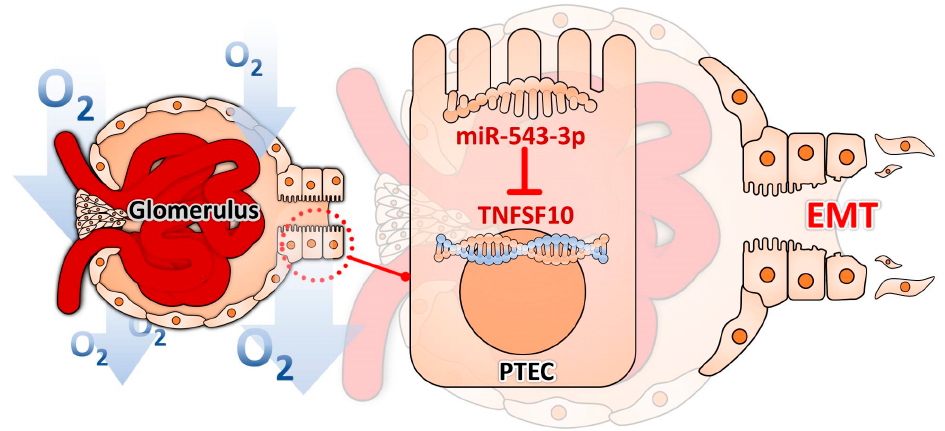
Figure 5. Illustration of the mechanism by which hypoxia induced EMT in PTECs through miR- 545-3p–TNFSF10.